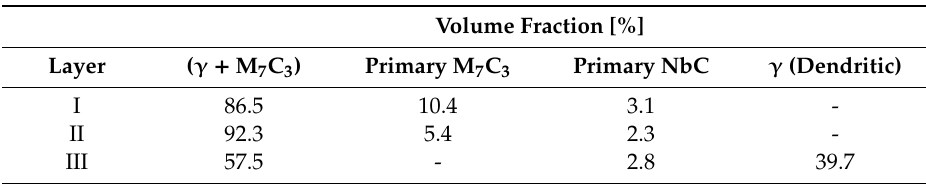
Figure 11. Graphic quantitative fraction of structure components. ( a ) Reference image for layer I, niobium carbides, primary chromium carbides, ( b ) Reference image for layer II, niobium carbides, primary chromium carbides, ( c ) Reference image for layer III, niobium carbides, dendritic austenite. Scanning electron microscopy. Table 2. Quantitative results of the fraction of structure components obtained on the basis of the graphic edition of the images shown in Figure 11.